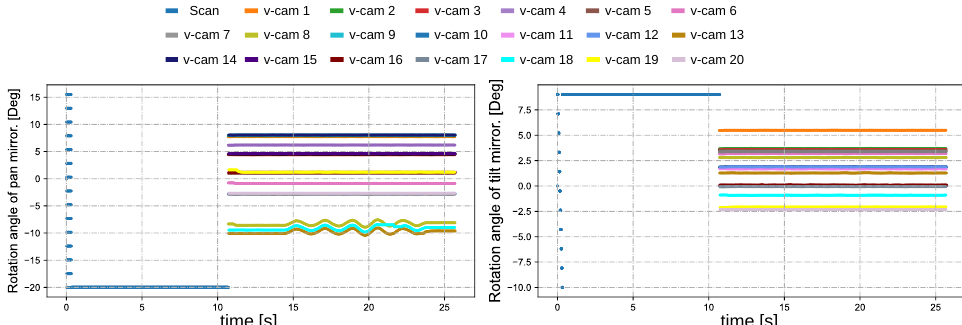
Figure 8. Pan and tilt angles of the galvanometer-based reflective PTZ camera when scanning and tracking twenty different